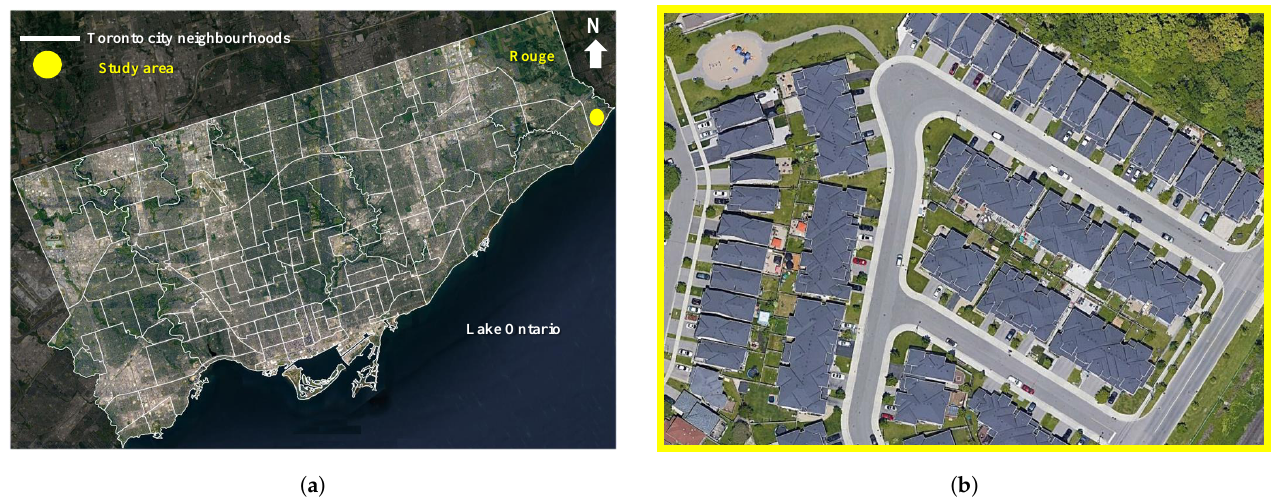
Figure 6. Study region. ( a ) Location of the study zone in Toronto. ( b ) Study area